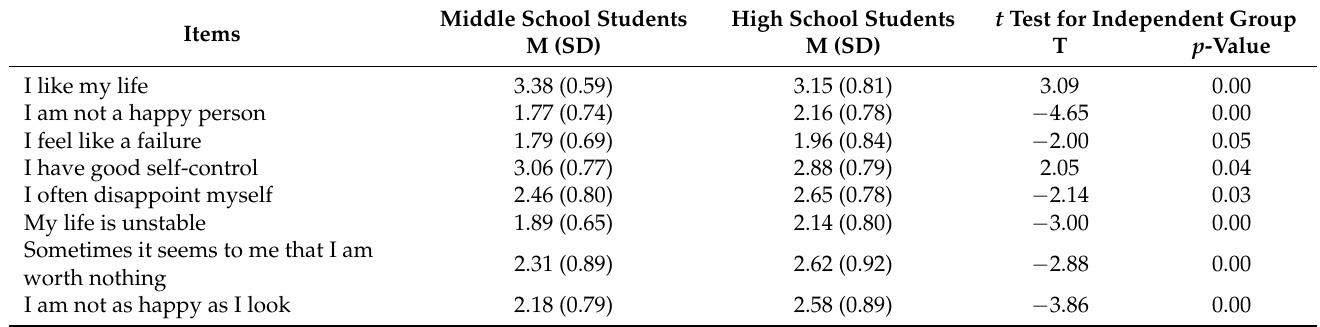
Table 3. The Independent Samples t Test: significant items of Emotional Competence Scale.